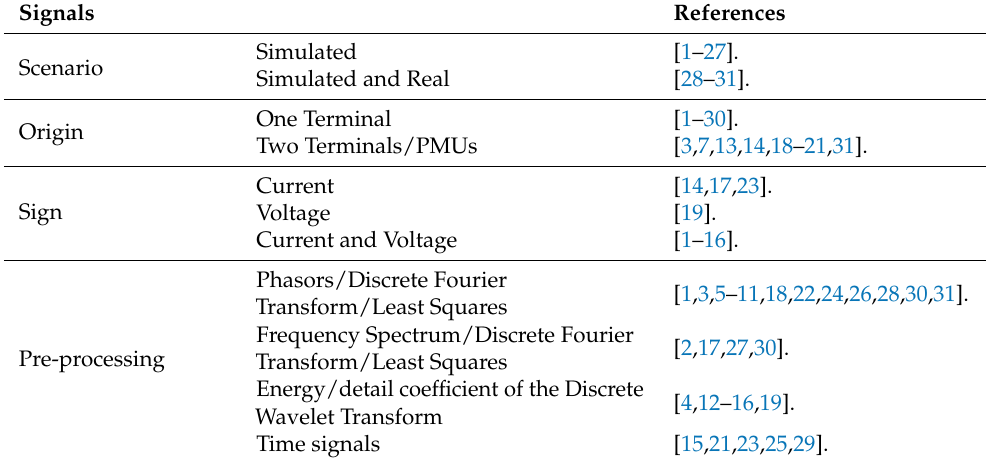
Table 1. Signal characterization and